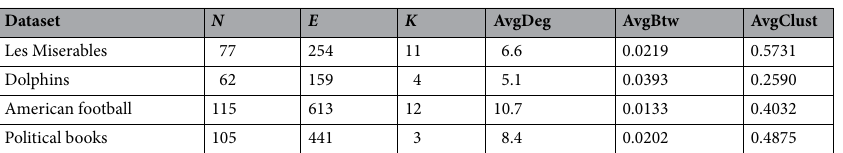
Table 1. Real networks description. We report statistics for the real networks used in our experiments. N and E denote the number of nodes and edges, respectively. K is the number of communities in the ground truth data. AvgDeg, AvgBtw and AvgClust are the average degree, betweenness centrality and average clustering coefficient,